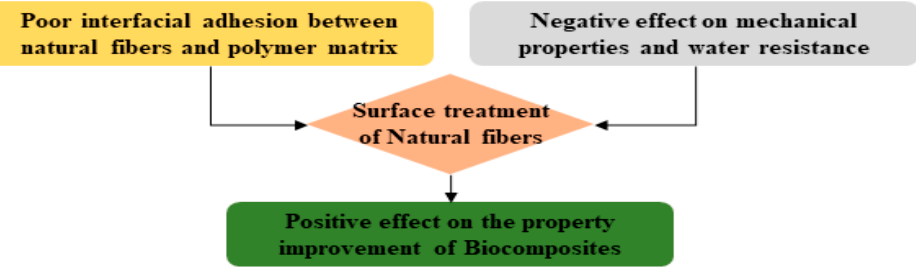
Figure 3. The need for surface treatment of natural fibers to improve the performance of biocompo- sites [14].